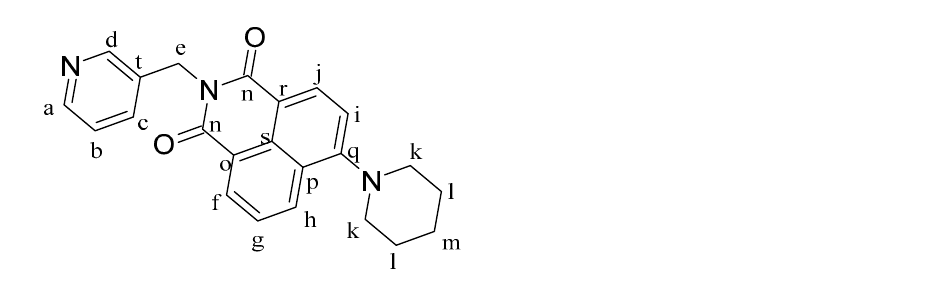
Figure 11. Structure of ligand 4-Piperidinyl- N -(3-methylenepyridyl)-1,8-naphthalimide (L3) . 4.2. General Procedure for the Intermediate Complexes IC1, IC2, and IC3